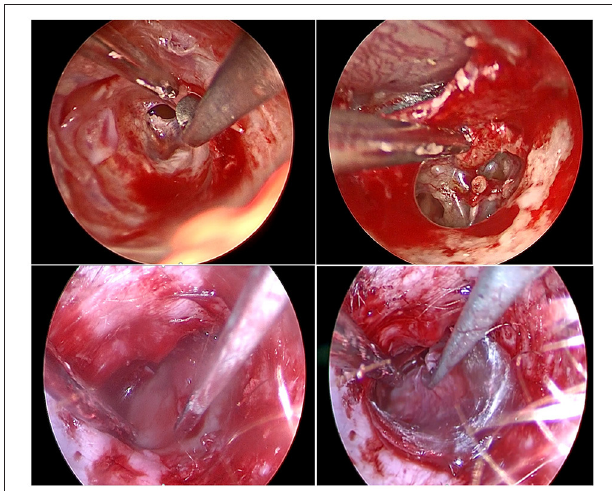
FIGURE 3 | Endoscopic view of various surgical steps during middle ear surgery. Top left, Skin incision and tympano-meatal flap raising; top right, Malleus handle dissection from tympanic membrane; bottom left, cartilage grafting placement; bottom right, temporal fascia grafting placement. Note that on all picture a suction and a tool are used for a two-handed technique in combination with an endoscopic exposure.